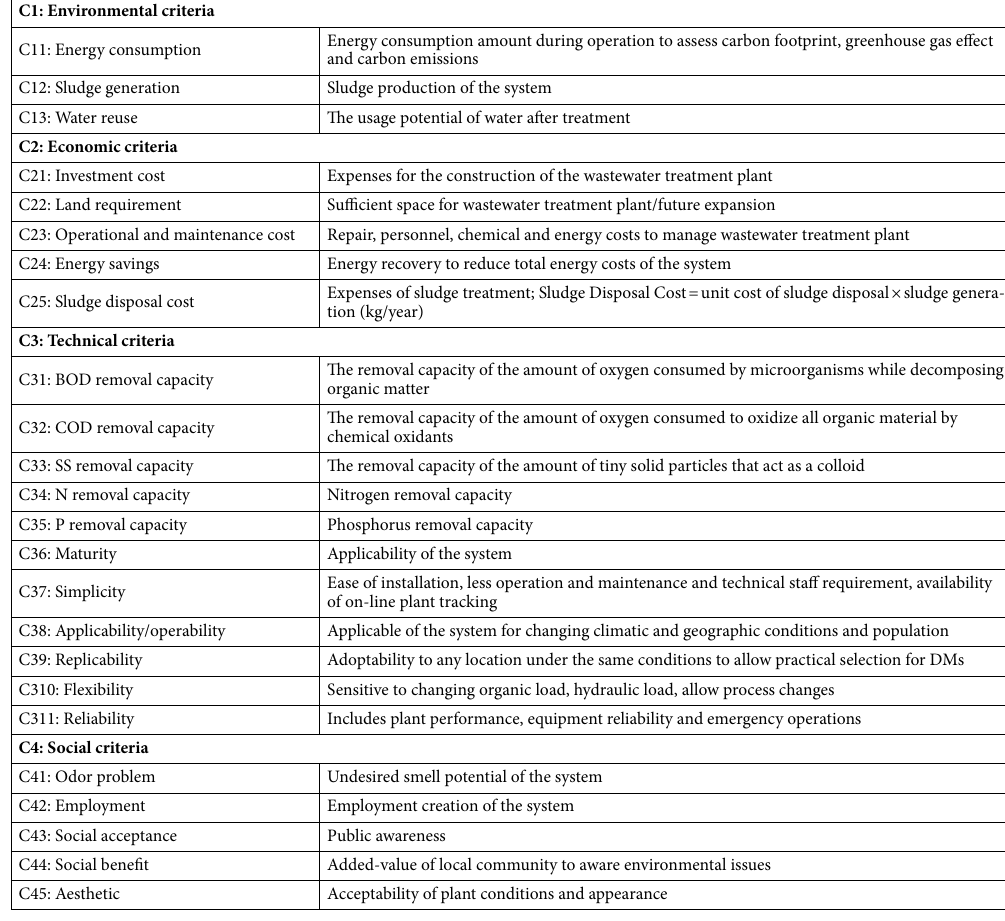
Table 1. Evaluation criteria for WWTP